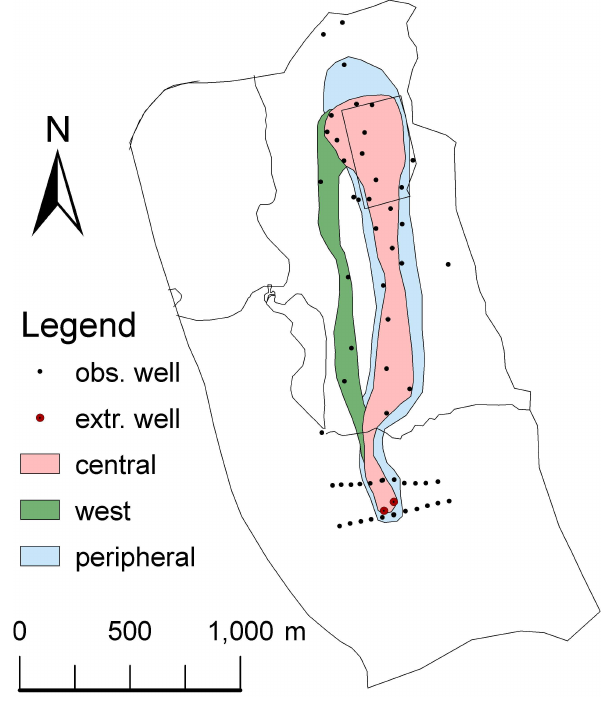
Fig. 5. Concentrations of BAM separated to central, western and peripheral plumes, in accordance with analyzed values (Ta- ble 2). The highest concentrations were found in the central plume, whereas the lowest concentrations were found in the peripheral